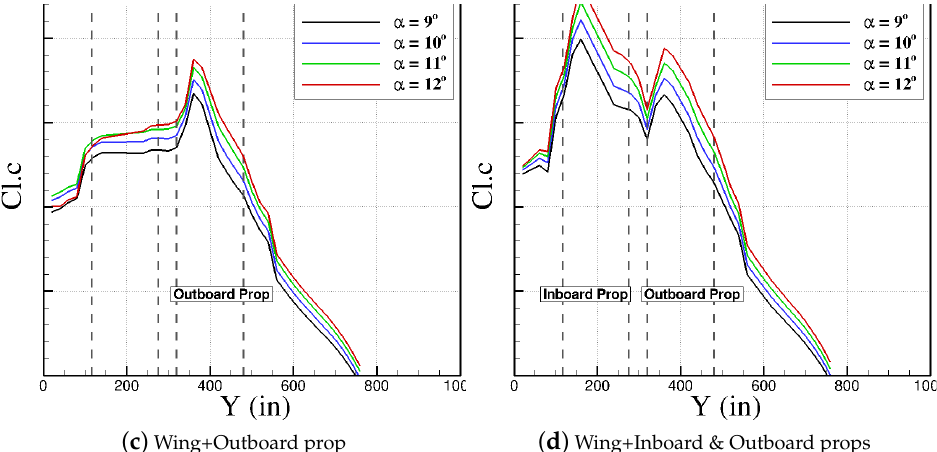
Figure 14. The wing stall behavior with and without propellers. All propellers spin counterclockwise.